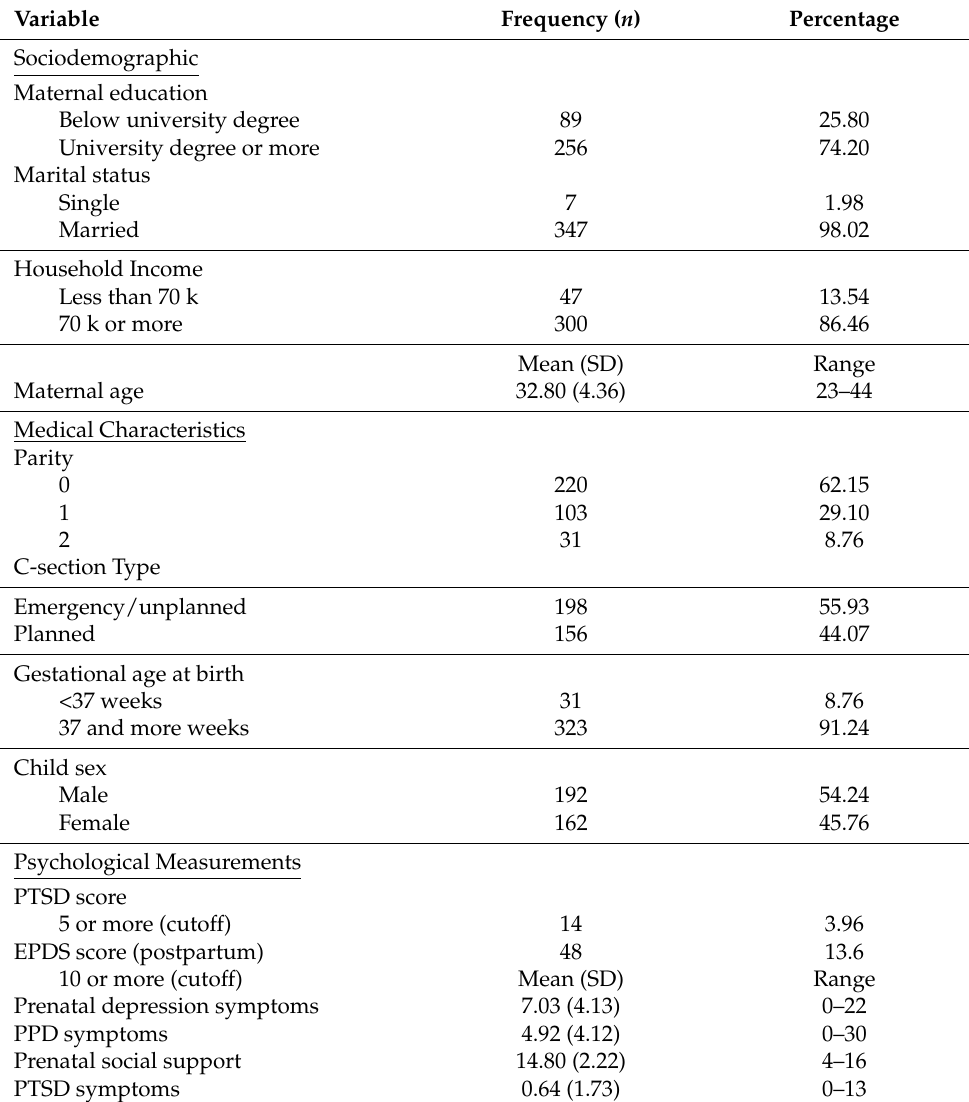
Table 1. Socio-demographic and descriptive characteristics of study participants n =